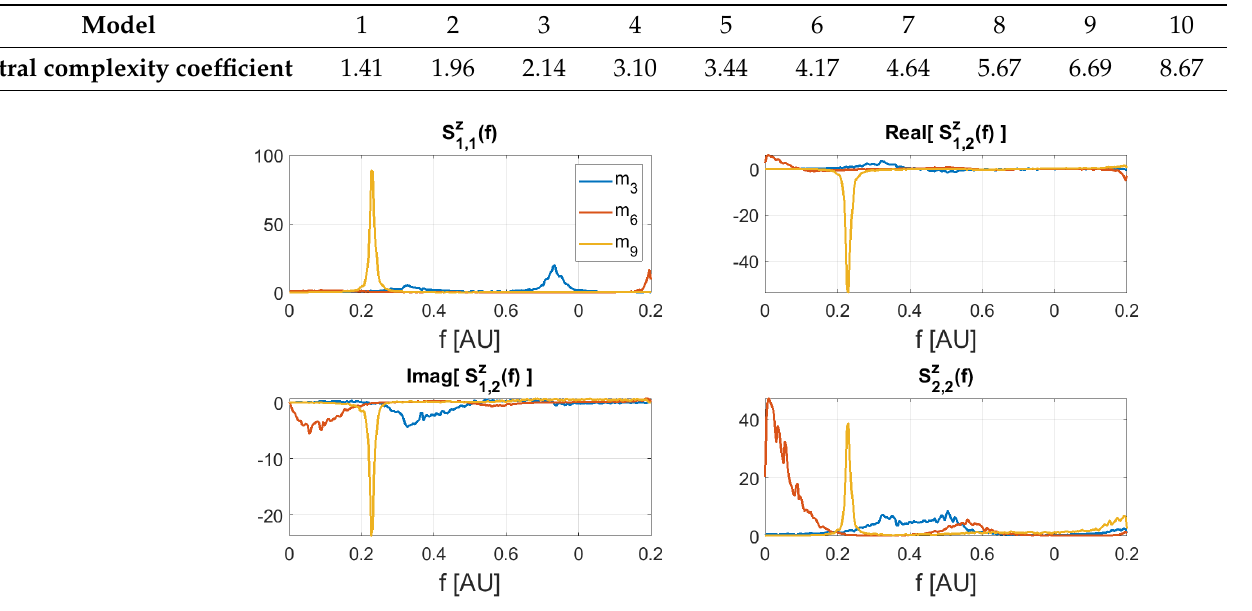
Table 1. The table reports the values of the spectral complexity coefficients, c j , associated to each simulated multivariate autoregressive (MVAR) model, m j , j = 1, . . . , N mod .